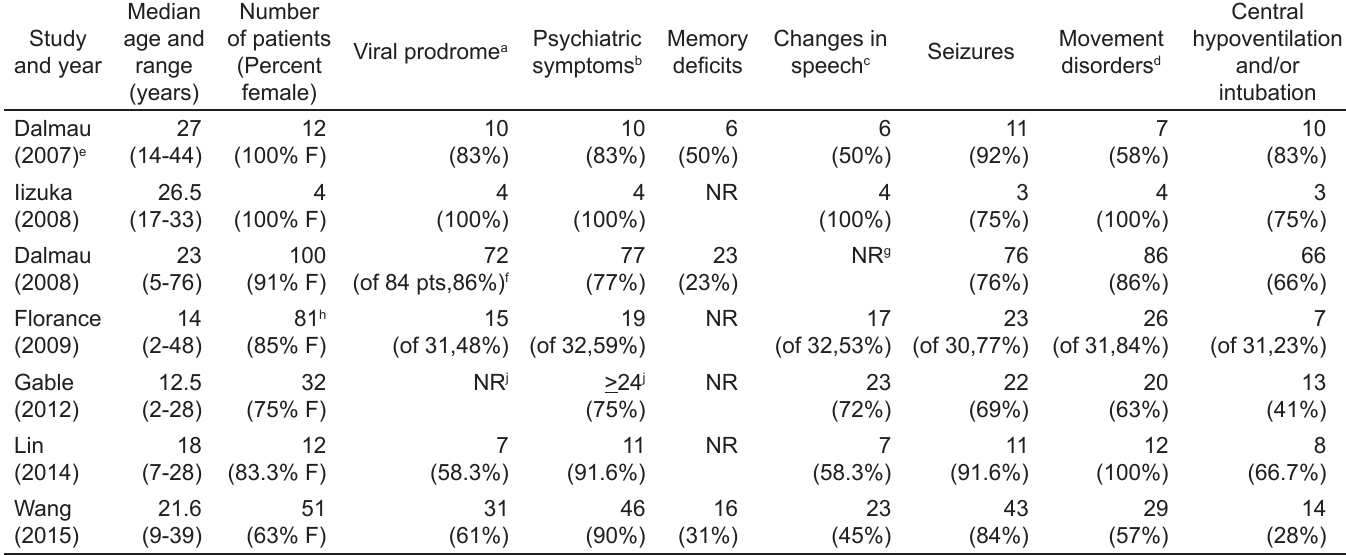
Table . Incidence of symptoms associated with anti-NMDA receptor encephalitis as described in previous